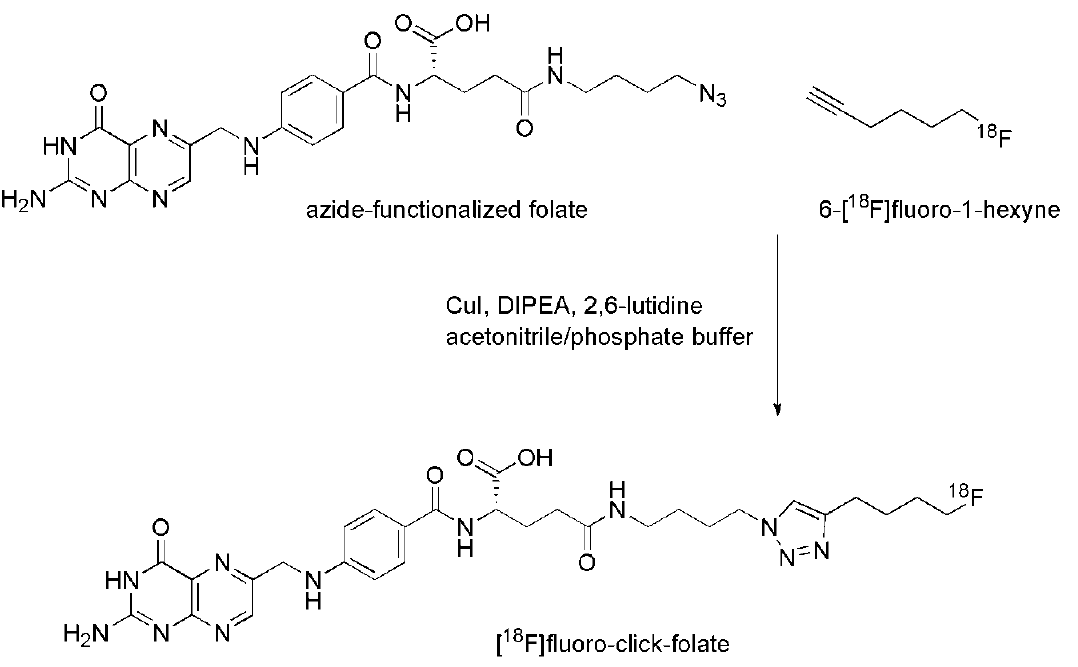
Figure 3. Radiosynthesis of [ 18 F]fluoro-click-folate [43] using an azide functionalized